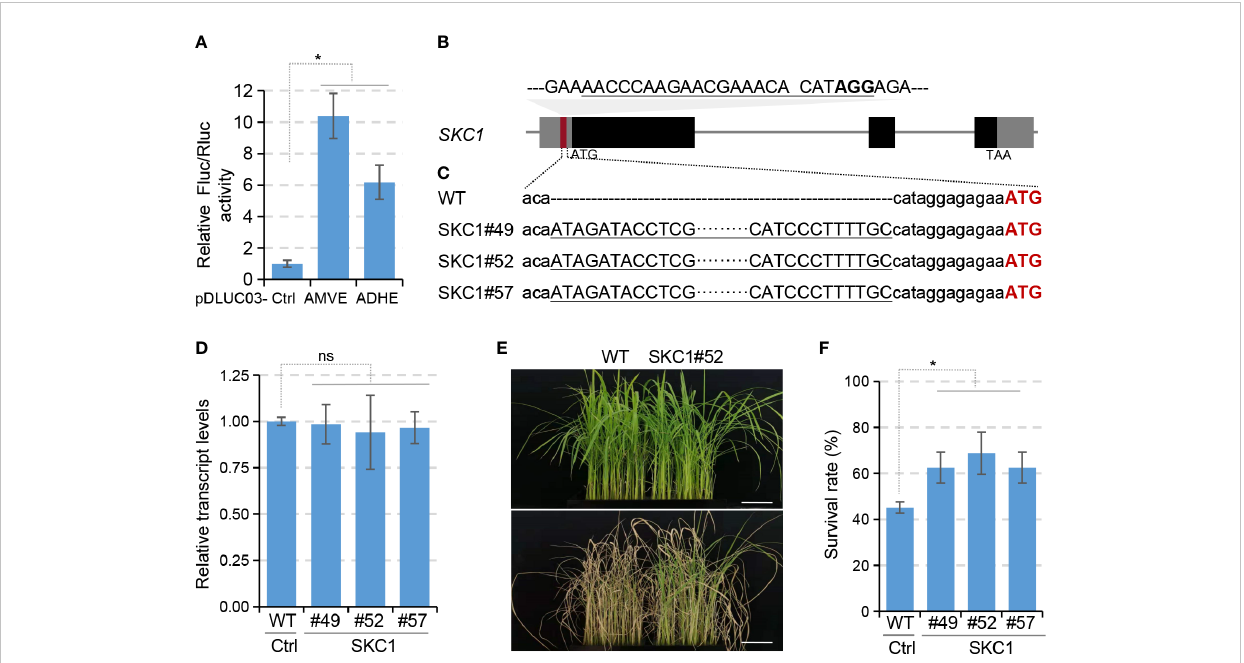
FIGURE 3 Knock-in of AMVE to improve salt tolerance of rice. (A) Assessment of enhancers ADHE and AMVE in protoplast-based dual-luciferase assays. Plasmids pDLUC02-SKC1 with or without (Ctrl) enhancer sequences were used as reporters. (B) Schematic diagram of SKC1 for AMVE knock-in. The sgRNA target of Cas9 is underlined with the PAM in bold. (C) Sequencing results of AMVE knock-in mutants. Sequences of AMVE were underlined and the start codon of SKC1 is in red. (D) Transcription levels of SKC1 in WT (Ctrl) and T2 mutants were determined using qRT-PCR. The rice Actin1 gene was used as the internal control. (E, F) Morphological and survival comparisons of the WT plants and T2 mutants in salt-stress treatment. Four- week-old rice seedlings (upper) were treated with 150 mM NaCl for 7 days (lower). Bar, 5 cm. (A, D, F) All values represent means ± s.d. of three independent experiments (n = 3). * P < 0.05; ns, no signi fi cant difference (two-tailed Student ’ s t